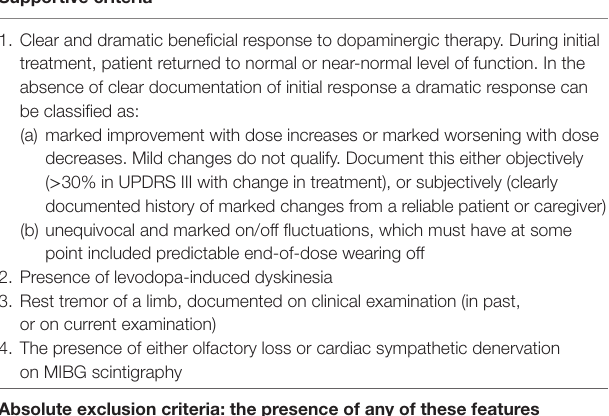
TABle 1 | Supportive criteria, absolute exclusion criteria, and red flags for the diagnosis of Parkinson’s disease, according to the revised International